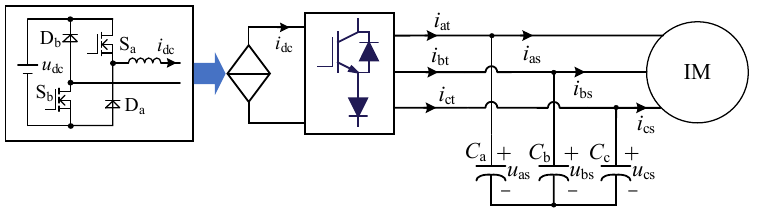
Figure 2. The equivalent circuit of CSI − fed IM drive system with bidirectional DC chopper.